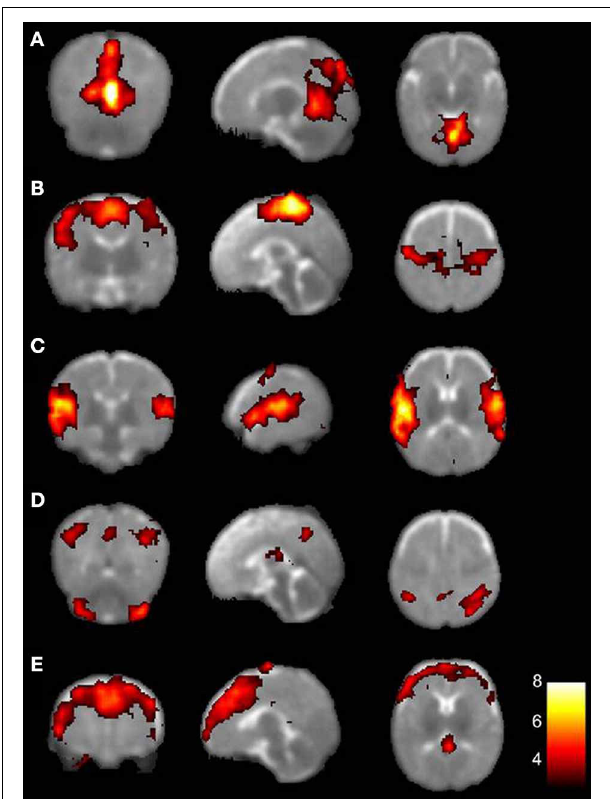
FIGURE 3 | The five resting-state networks consistently found in preterm infants. Each row depicts one resting-state network represented on an axial T2-weighted template, with on the left hand side the left hemisphere. Colors indicate correlation strength, with increasing correlation strength toward the yellow part of the spectrum. (A) primary visual areas; (B) bilateral somatosensory and motor cortices; (C) bilateral temporal/inferior parietal cortex encompassing the primary auditory cortex; (D) posterior lateral and midline parts of the parietal cortex and lateral aspects of the cerebellum; (E) medial and lateral sections of the anterior prefrontal cortex. With permission reproduced from (Fransson et al., 2007). Copyright National Academy of Sciences, U.S.A.